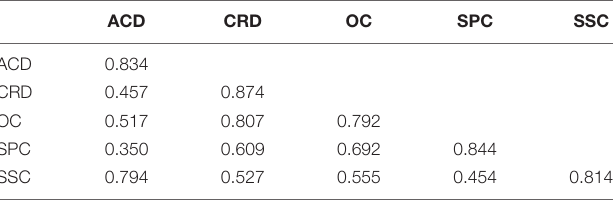
TABLE 4 | Fornell and Larcker